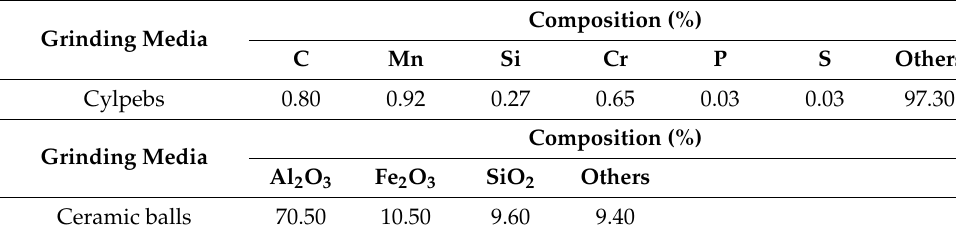
Table 2. Composition properties of grinding media.